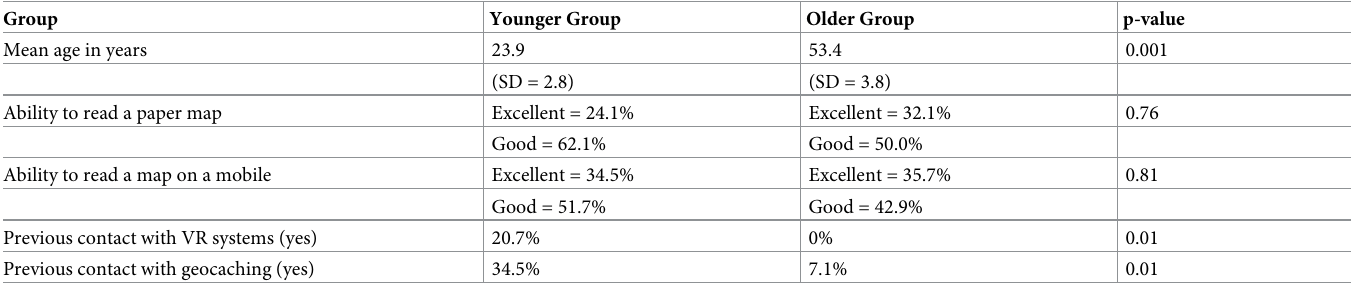
Table 1. Distribution of participant age, and survey results of the participants’ self-assessment on their ability to read a map (i.e. paper or on a mobile phone), and on their previous contact with virtual reality systems and geocaching. Group Younger Group Older Group p-value Mean age in years 23.9 53.4 0.001 (SD = 2.8) (SD = 3.8) Ability to read a paper map Excellent = 24.1% Excellent = 32.1% 0.76 Good = 62.1% Good = 50.0% Ability to read a map on a mobile Excellent = 34.5% Excellent = 35.7% 0.81 Good = 51.7% Good = 42.9% Previous contact with VR systems (yes) 20.7% 0% 0.01 Previous contact with geocaching (yes) 34.5% 7.1% 0.01 For statistical comparison between the Younger and Older groups, p-values are provided. SD = standard